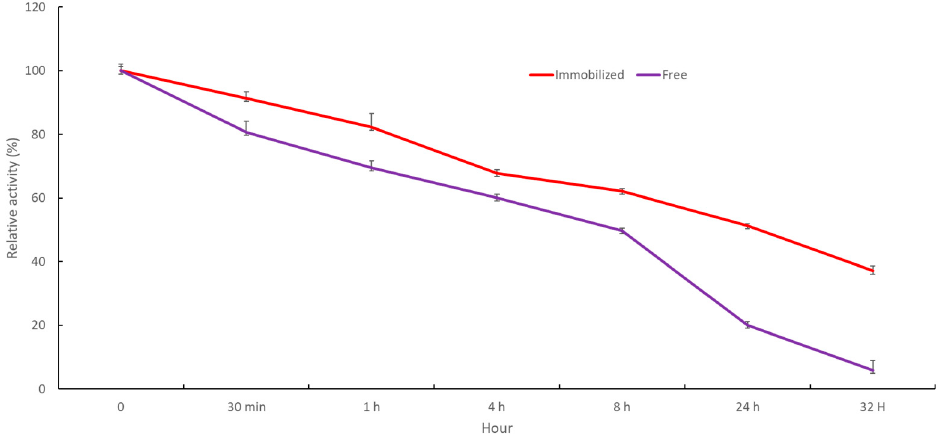
Figure 5. Effect of thermostability on immobilized and free YT PTE. Red line: Immobilized YT PTE; Purple line: Free enzyme.